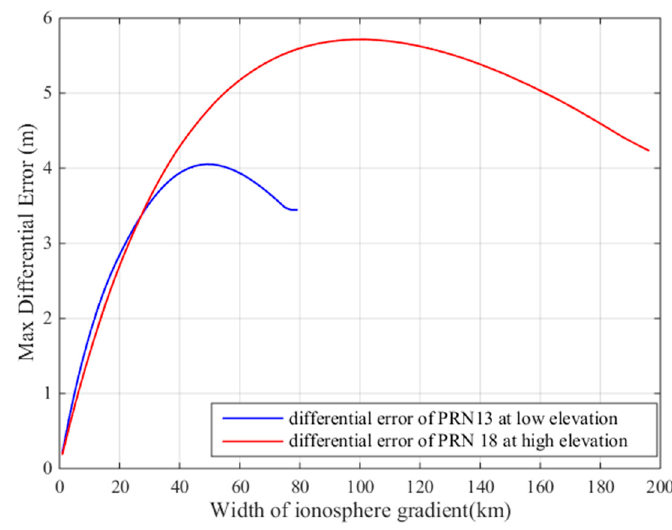
Figure 21. Differential error vs. ionospheric gradient width.